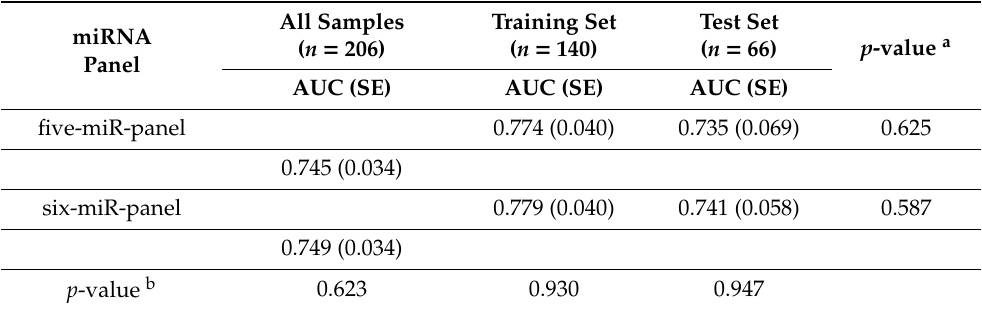
Table 5. Comparison of the C-statistics of prognostic indices for BCR prediction using two miRNA panels in Cox regression